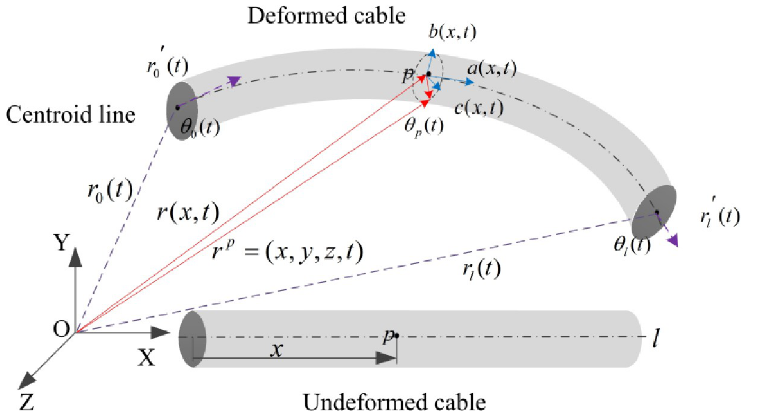
Fig 12. Geometric description of generalized coordinates and deformation of cable.